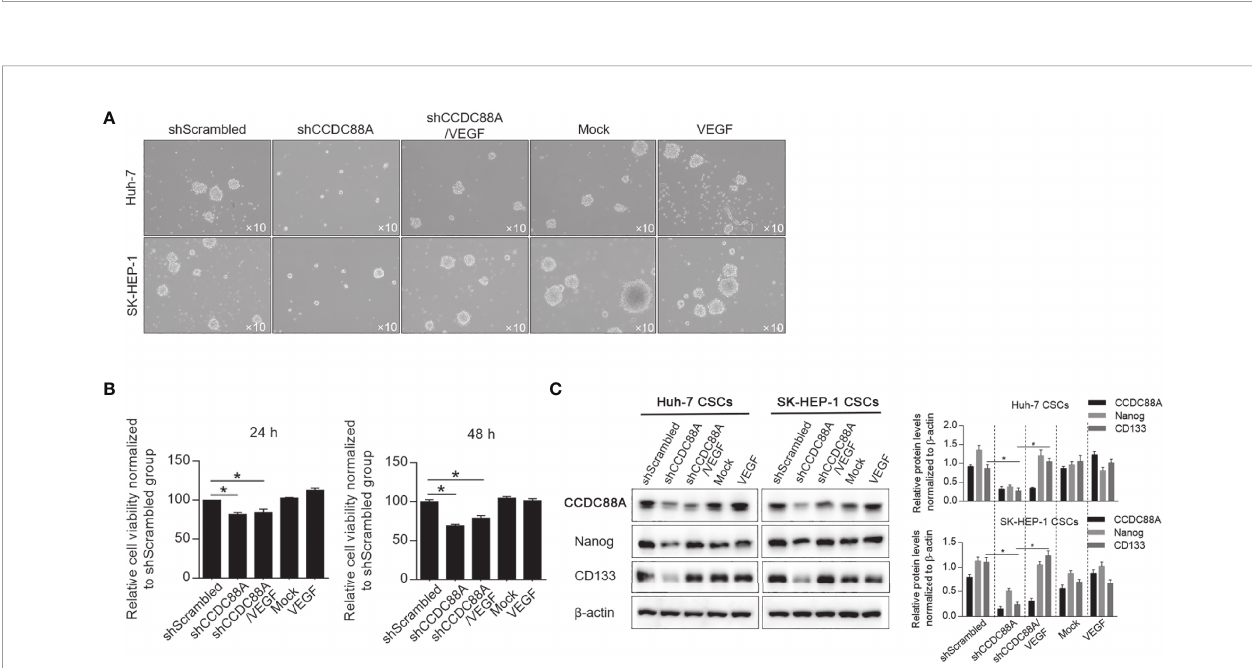
FIGURE 10 | CCDC88A regulates stemness of CSCs via modifying VEGF. (A) After CCDC88A silencing with or without VEGF addition, sphere formation of Huh-7 and SK-HEP-1 in serum-free medium was collected. (B) After CCDC88A silencing with or without VEGF addition, cell viability was measured by performing CCK-8. *P<0.05, vs. shScrambled group. (C) After CCDC88A silencing with or without VEGF addition, expression of Nanog and CD133 were semi-quantitatively analyzed by western